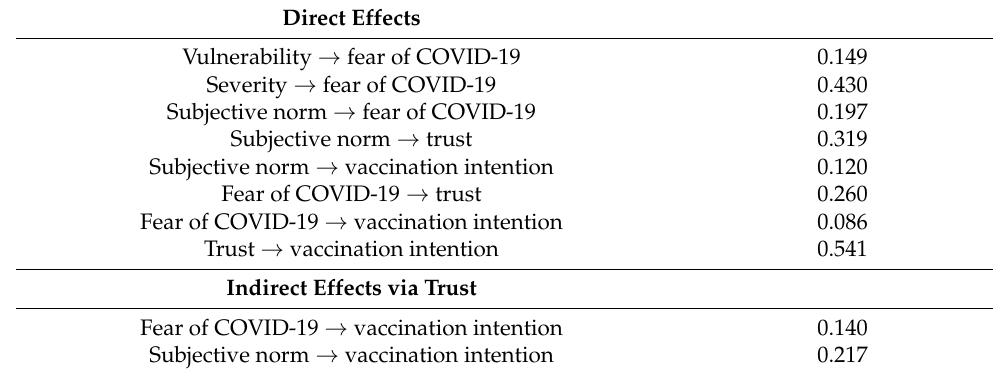
Table 3. Direct and indirect standardized path coefficients (regression weights) of the